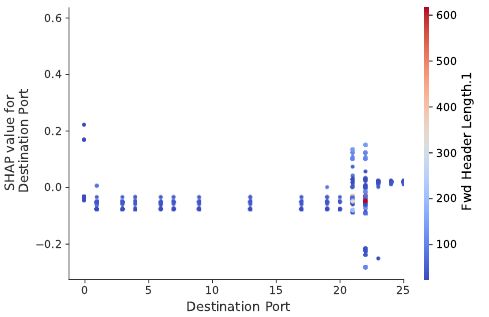
Figure 7. Fwd Header Length.1/Destination Port interaction for port scan